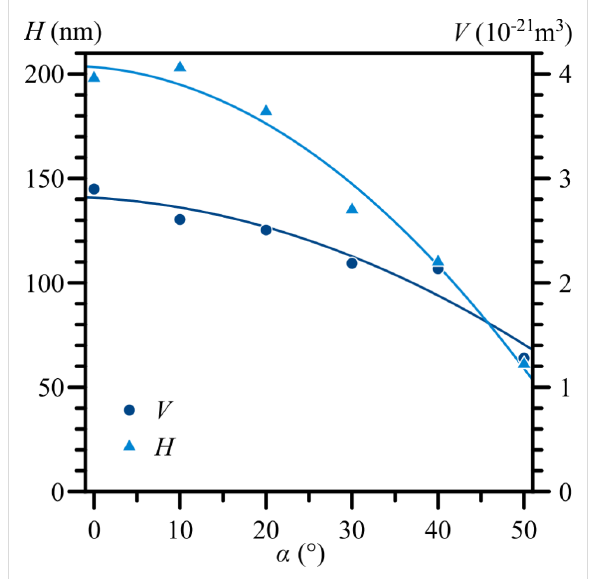
Figure 2: The volume and height of nanostructures on an Ag surface as functions of the electron beam current I and diameter d . Constant beam parameters are: U = 30 kV, t = 40 s, and α = 0°.